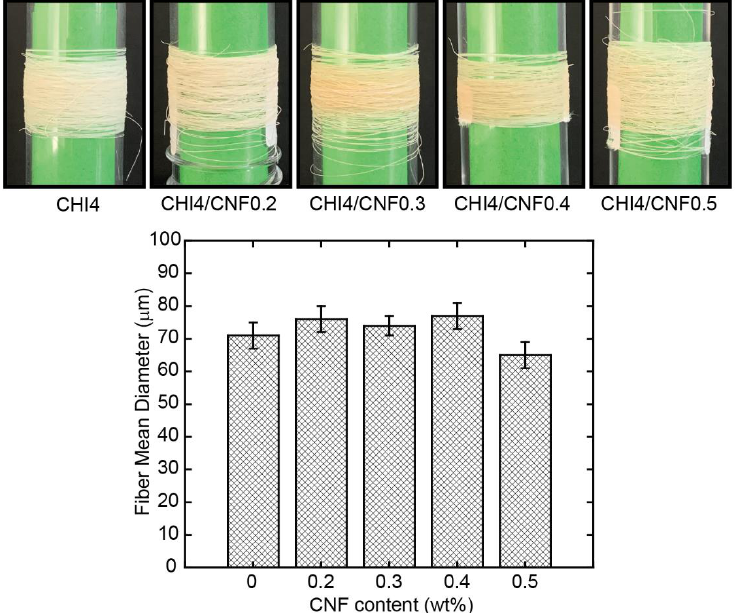
Figure 4. ( Top ) Photos of the obtained CHI/CNF spun fibers of varied compositions. ( Bottom ) Histogram showing the mean CHI/CNF fiber diameter obtained with the different CHI/CNF collodion formulations.